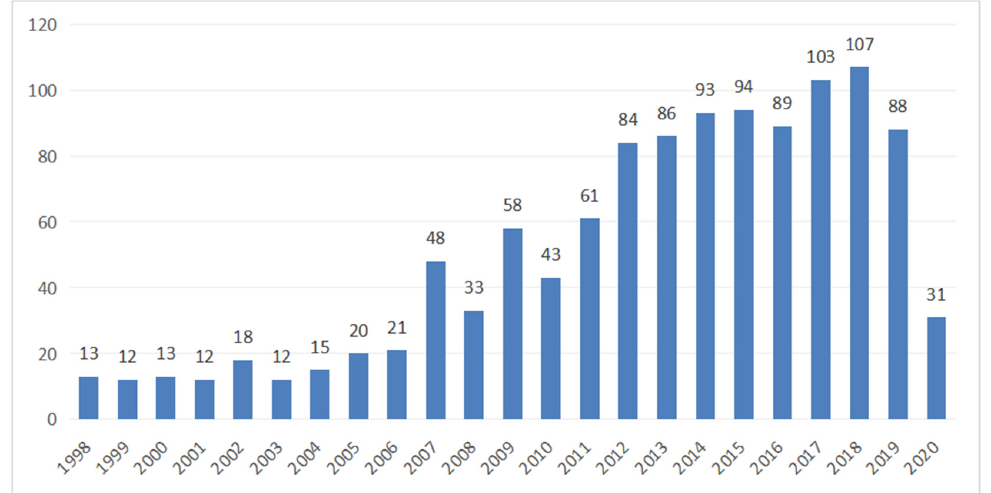
Figure 2. The number of EPW HMI methodology research publications indexed by the Web of Science from 1998 to 2020.